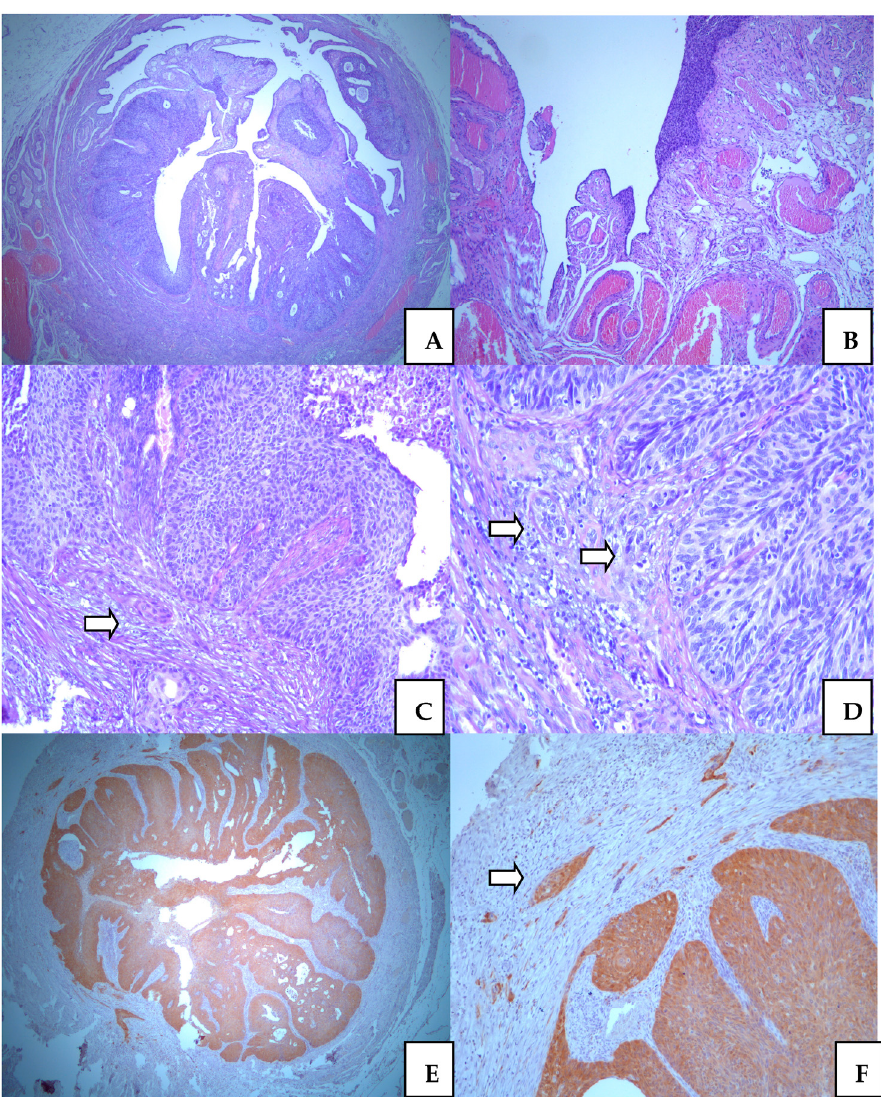
Figure 4. Squamocellular carcinoma in the uterine tuba. Intraepithelial neoplastic lesion replaces normal tubal epithelium (( A ). ×25, and ( B ). ×50); Microinvasive foci (arrows) in surronding fibrous tissue of tubal wall (( C ). ×100, and ( D ) ×100); Positive p16 immunostaining in neoplastic epithel with remarkable expression in micorinvasive foci (arrow) (( E ). ×25, and ( F ). ×100).